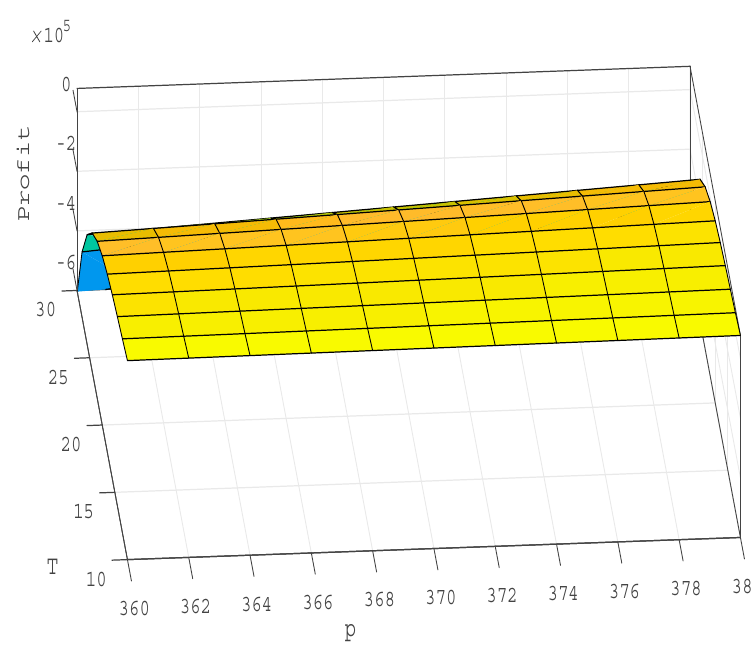
ψ * regarding decision variables selling price (p) and cycle length (T). Figure 3. Concave graph of Figure 3. Concave graph of ψ ∗ regarding decision variables selling price (p) and cycle length (T).